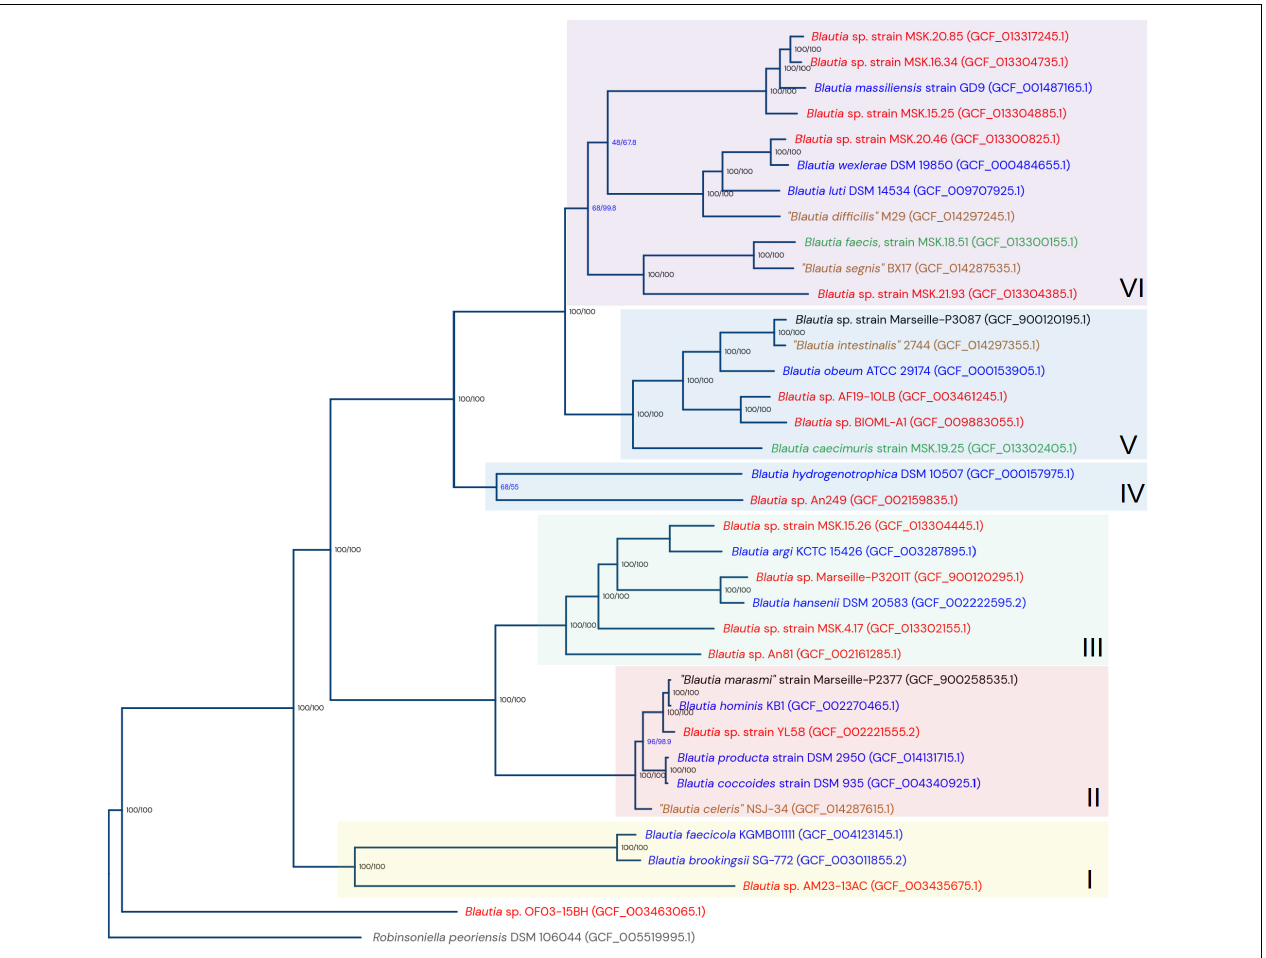
FIGURE 1 | Phylogenomic tree from selected representative genomes from the clusters of genomic species from the Blautia dataset. The tree was computed using maximum likelihood, from the concatenated sequence alignment of 190 conserved single-copy orthogroups. The numeric data in format n/n represent values for bootstrap support (UF-bootstrap) and approximate likelihood-ratio test values (SH-aLRT). The tree is rooted using Robinsoniella peorensis data as the outgroup. The arbitrarily designed lineages I to VI are also shown. The color of each taxon name reflect the status of the current representative genome: red: undescribed potential new species; blue: type strain of a validated species; green: strain of a validated species, but not a type strain; brown: proposed type strain from a non-officially accepted species; black: current strains reassigned into another species. See text for more details.